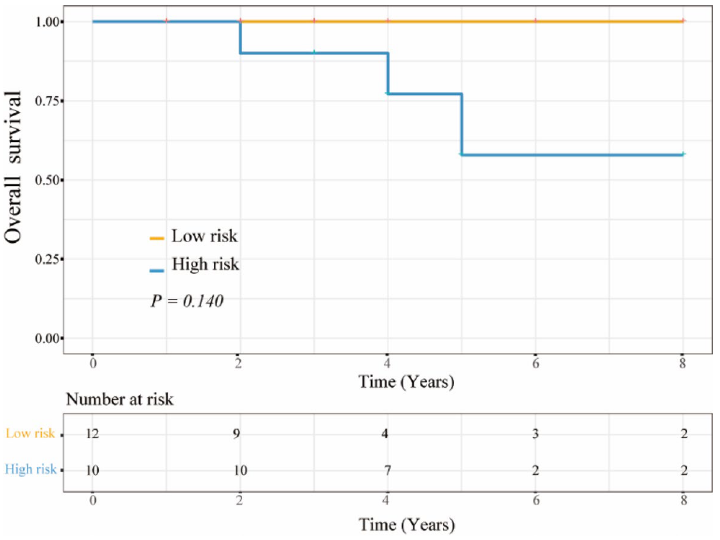
Figure 2. Comparison on the survival curves of low- and high-risk patients without adjuvant chemotherapy based on